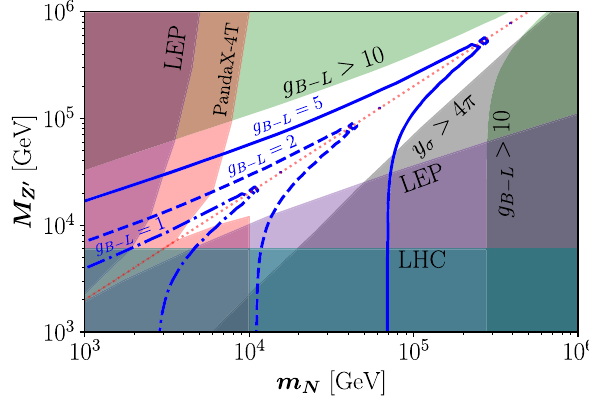
Fig. 5 Fermionic DM. Contours for the coupling g B − L required in ordertoreproducethewholeobservedDMabundance(thickbluelines). The color-shaded areas are in tension with LHC searches for Z (cid:2) gauge bosons (blue), LEP measurements of e + e − → (cid:7) + (cid:7) − (purple), direct DM searches from PandaX-4T (red), and the perturbative bounds on g B − L (green) and y σ (gray). The red dotted line corresponds to 2 m N = M Z (cid:2) cross section per nucleon. PandaX-4T results provide strong bounds to this scenario with large g B − L couplings, con- straining spin-independent cross section up to DM masses of 10 TeV. Lighter DM masses ( m N (cid:3) 3 TeV) are only allowed near the resonance m N (cid:9) 2 M Z (cid:2)